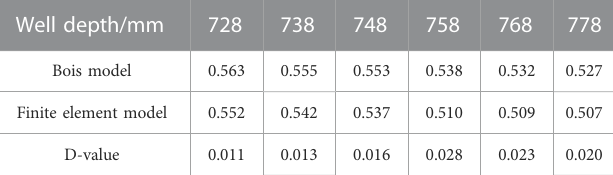
TABLE 2 Comparison between numerical model and Bois model to calculate micro-ring gap size.